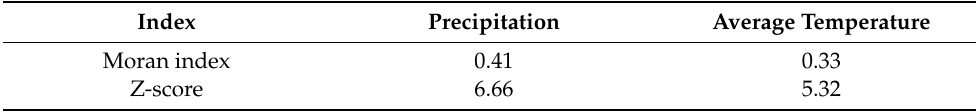
Table A1. Spatial autocorrelation test